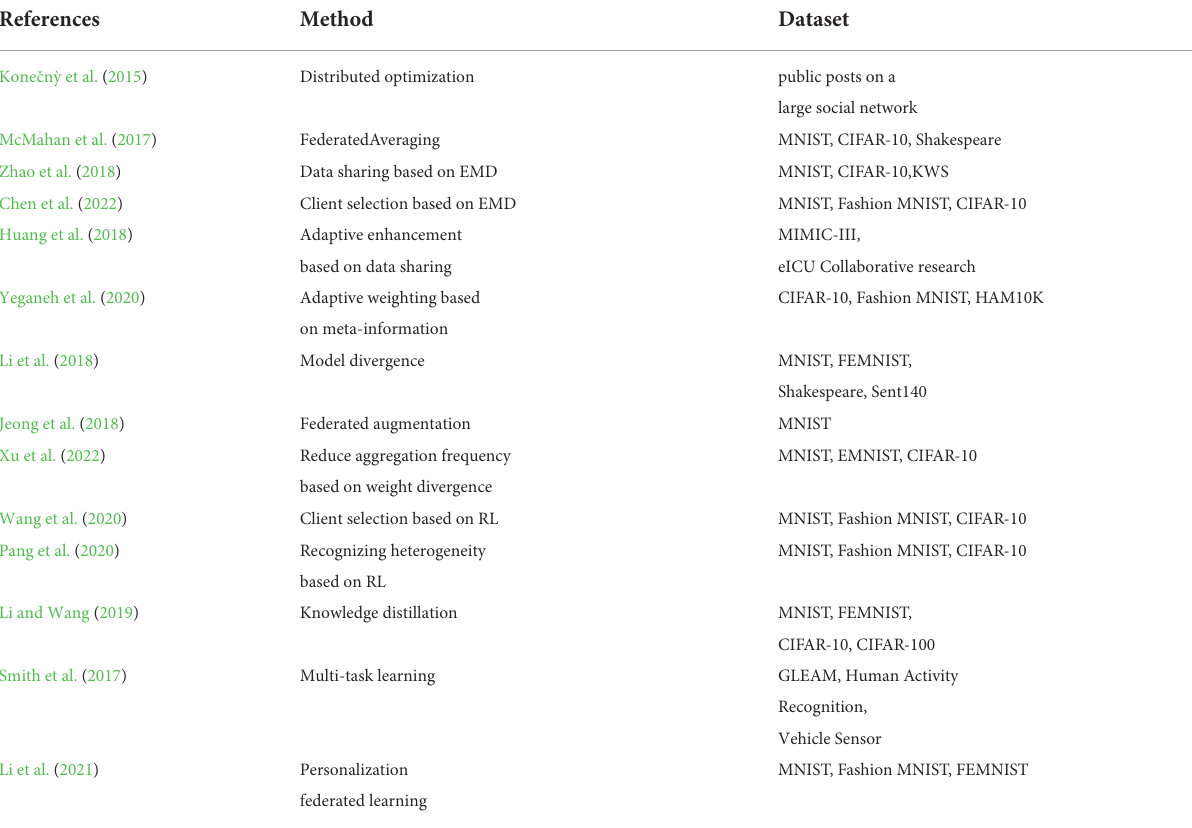
TABLE 1 Federated learning for data